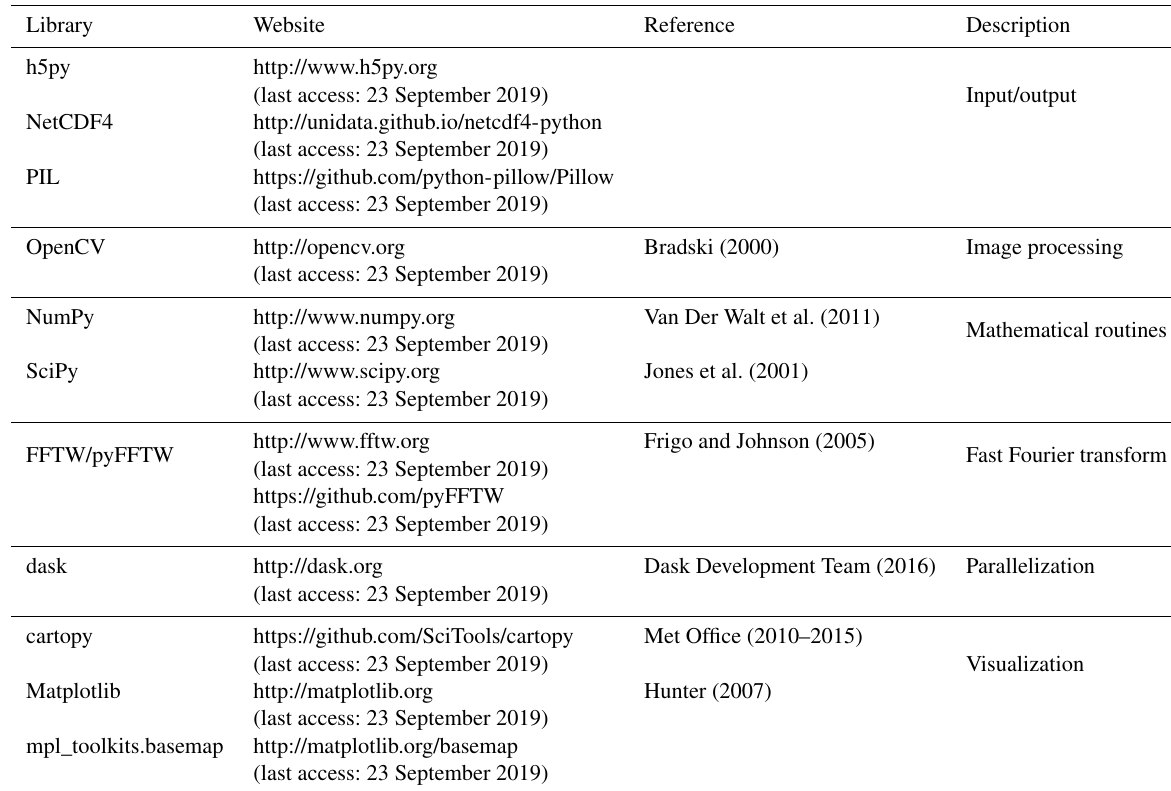
Table 2. External libraries used by